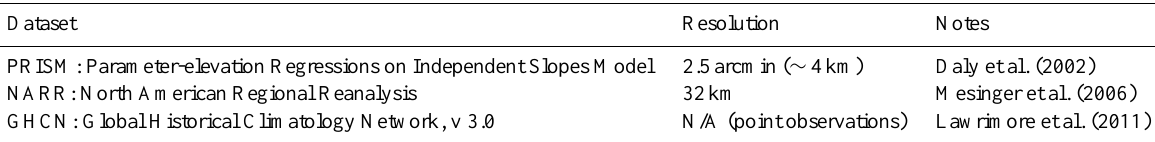
Table 1. Meteorological datasets used.